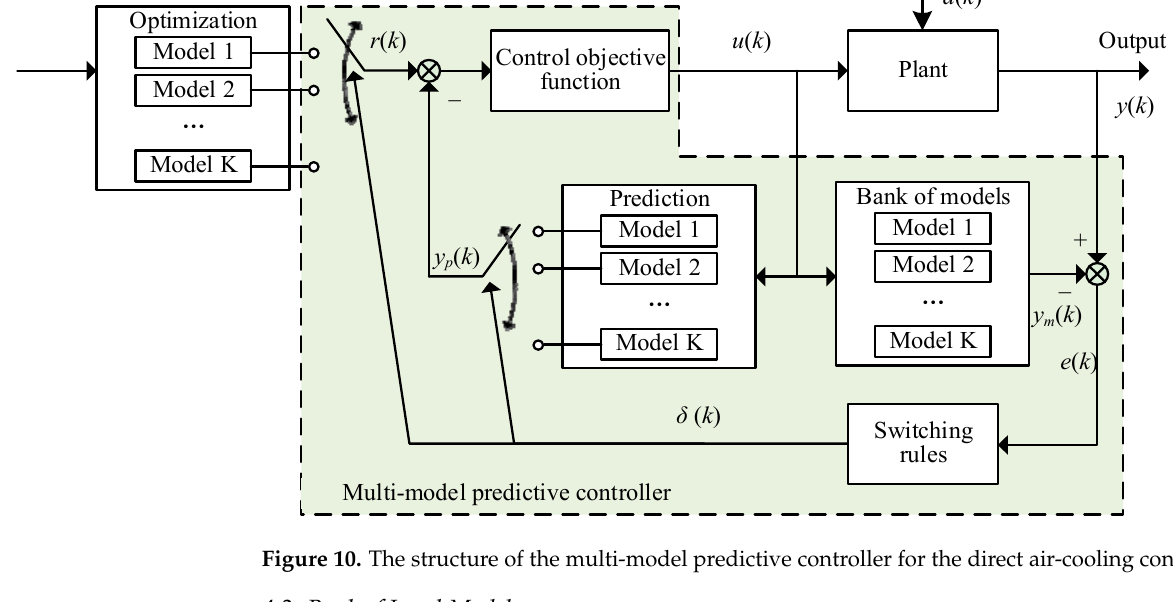
90° (b) Figure 11. Schematic of divisional regulation of fan array under different wind directions: ( a ) in wind direction 0°; ( b ) in wind direction 90°; ( c ) in wind direction 270°; ( d ) in wind direction 180°. When the wind direction is 90°, the influence of ambient wind on the airflow of the direct air-cooling condenser is axisymmetric with that of when the wind direction is 270°. Therefore, this paper shows the controller performance by switching between the three models in Figure 11a,c,d. When the ambient wind speed was 6 m/s, the plume recircula- tion rate and volumetric effectiveness were measured by field experiments and scaled- down model experiments, respectively. The establishment of the scaled-down fan array model and experiments are introduced in [20]. The parameters are shown in Table 2. The plume recirculation caused by ambient wind gradually decreased in the order of wind direction angles of 180°, 270°, and 0°. The plume recirculation rate and wind direction